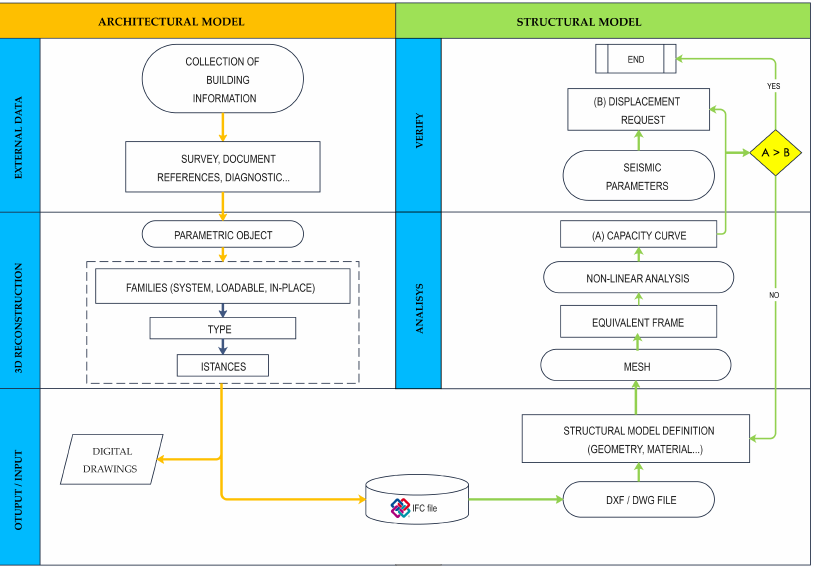
Figure 8. Flow process for HBIM modeling and seismic safety